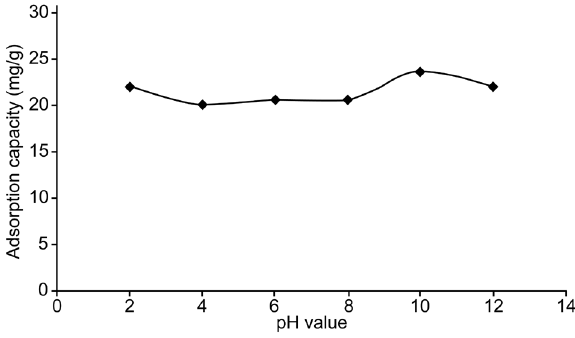
Figure 3: Total glycoside content at different concentrations.